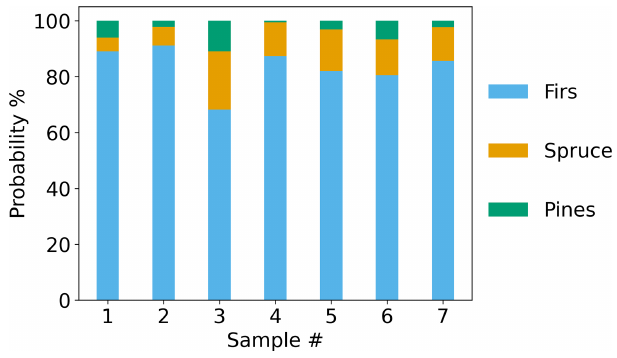
Figure 15. Classification probability by fuel class for plot 340.